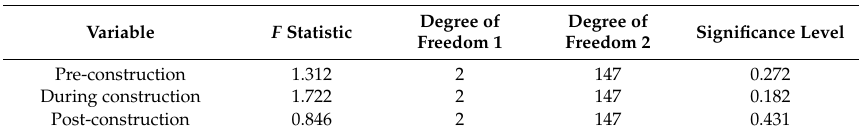
Table 7. The Levene’s test results.